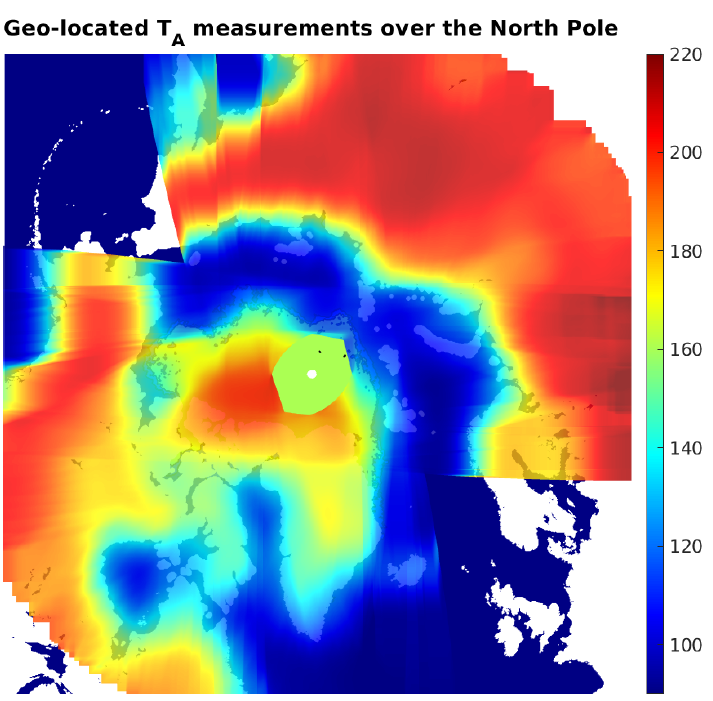
Figure 11. Reconstructed 2D antenna temperature ( T A ) (K) image over the North Pole by aggregation of multiple scattered FMPL-2 executions over an EASE Grid of 3 km. Note that, transparency is added to show land